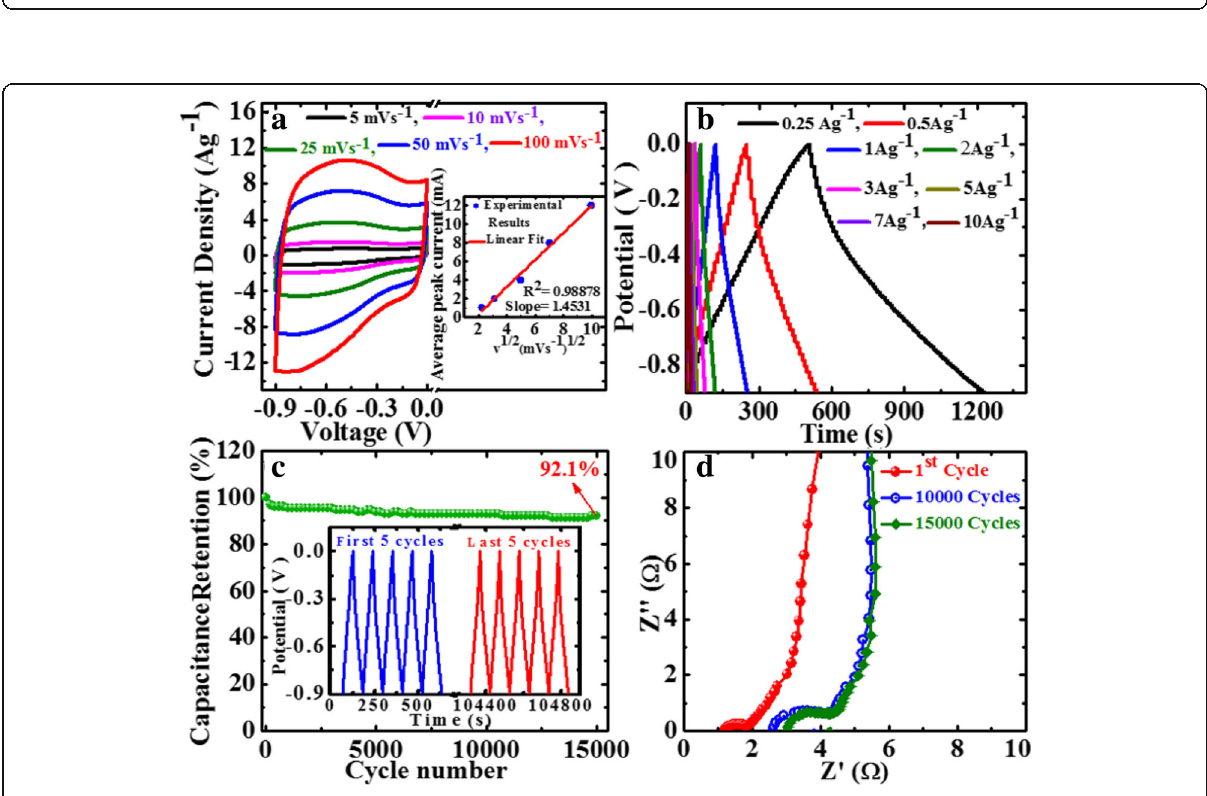
Fig. 10 Electrochemical performance of GP10C in 2M KOH electrolyte a CV curves at the scan rate of 5, 10, 25, 50, and 100mVs − 1 ; b GCD curves at the current densities of 0.25, 0.5, 1.0, 2.0, 3.0, 5.0, 7.0, and 10Ag − 1 ; c cyclic stability performance for GP10C electrode at 2Ag − 1 and inset shows the GCD curves of first and last 5cycles; and d Nyquist plot for the GP10C and inset shows the EIS performance during 1st, 10,000 and